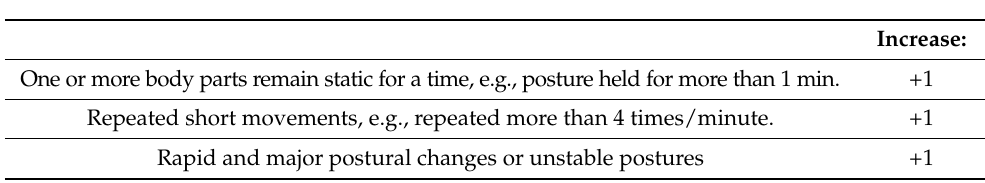
Table 6. Score Increase.